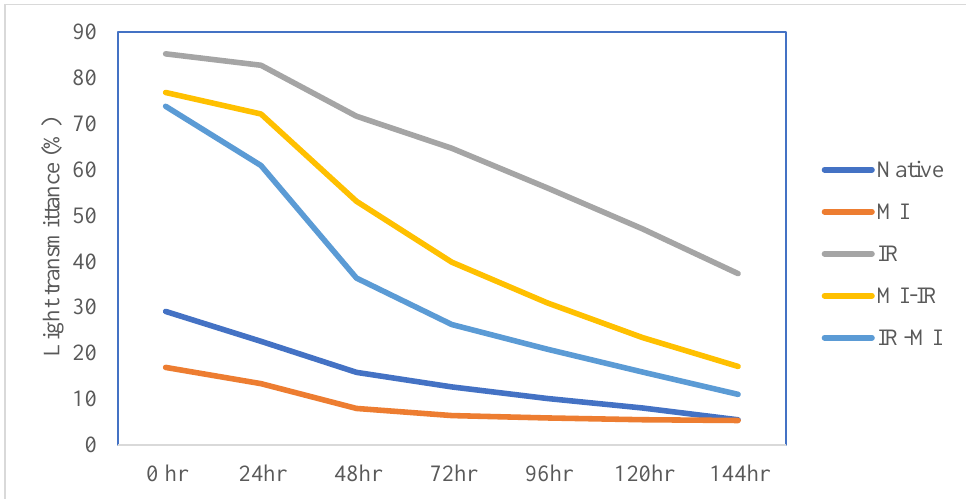
Figure 1. Effect of storage duration on light transmittance (%) of native and modified lotus rhizome starch pastes.